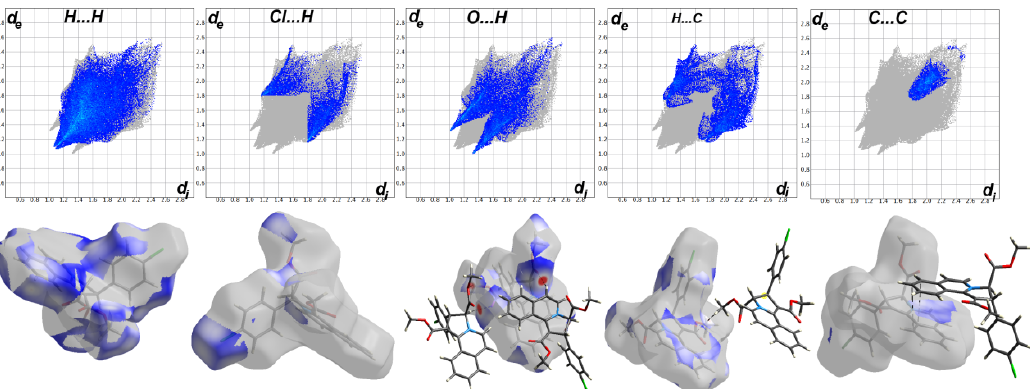
Figure 5. Decomposed fingerprint plots and d norm surfaces in 3 .